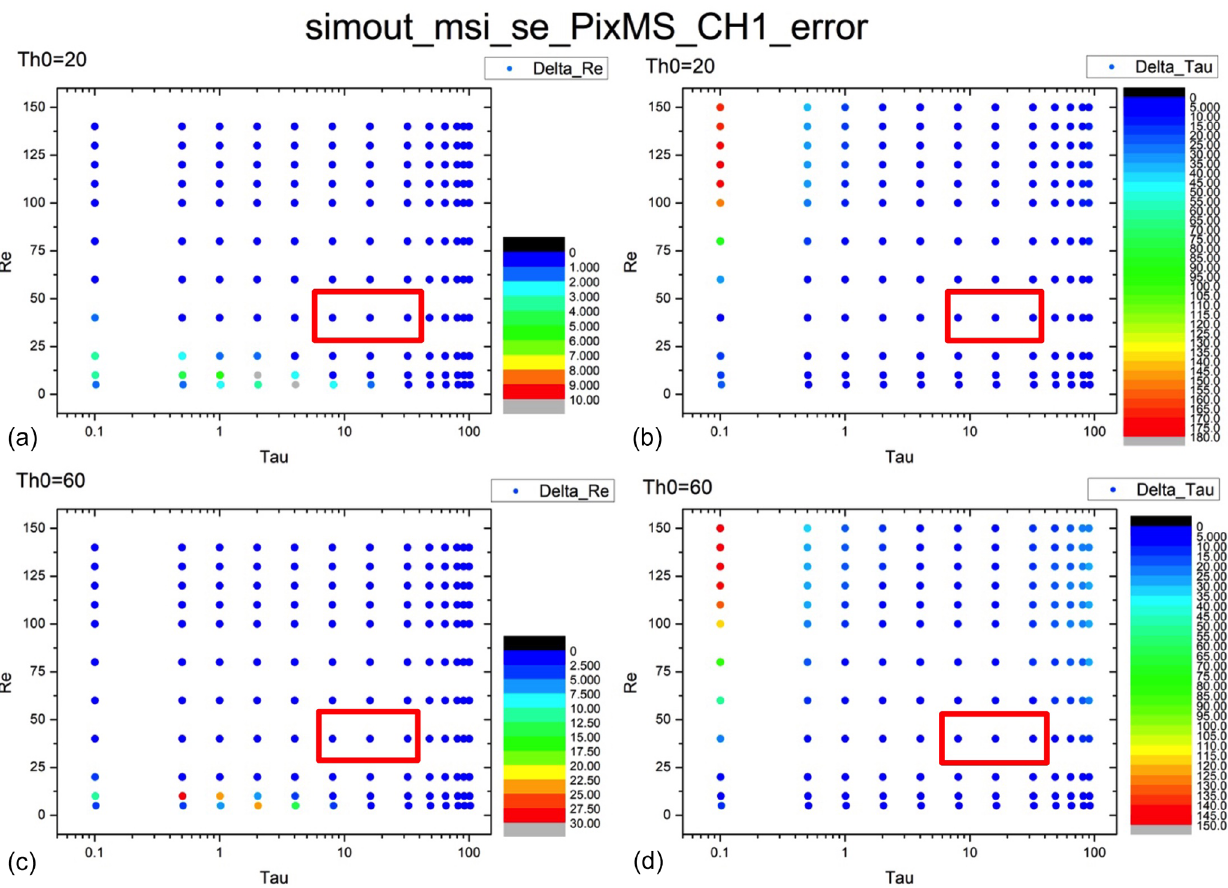
Figure 11. Error distributions of COT and CDR from the Nakajima–King diagram for deep convective clouds at pix_BND1_min. (a) Distri- bution of (cid:49)r e for a solar zenith angle of 20 ◦ . (b) Distribution of (cid:49)τ for a solar zenith angle of 20 ◦ . (c) Distribution of (cid:49)r e for a solar zenith angle of 60 ◦ . (d) Distribution of (cid:49)τ for a solar zenith angle of 60 ◦ . The red frames show the presence of typical deep convective clouds. COT = 8 or 32, CDR = 40µm.